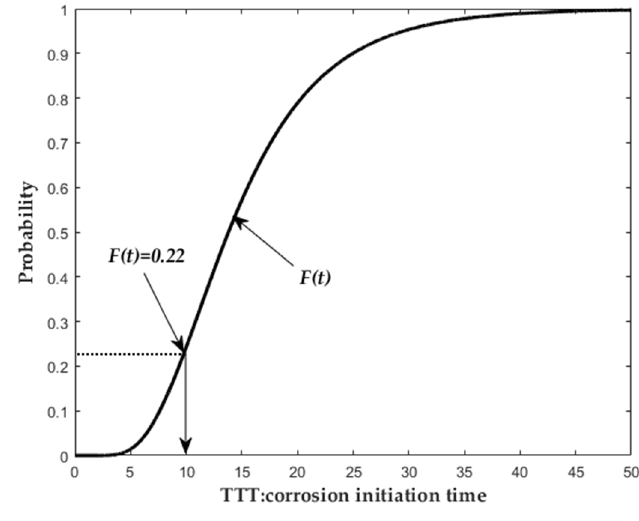
Figure 5. Cumulative probability of transition.